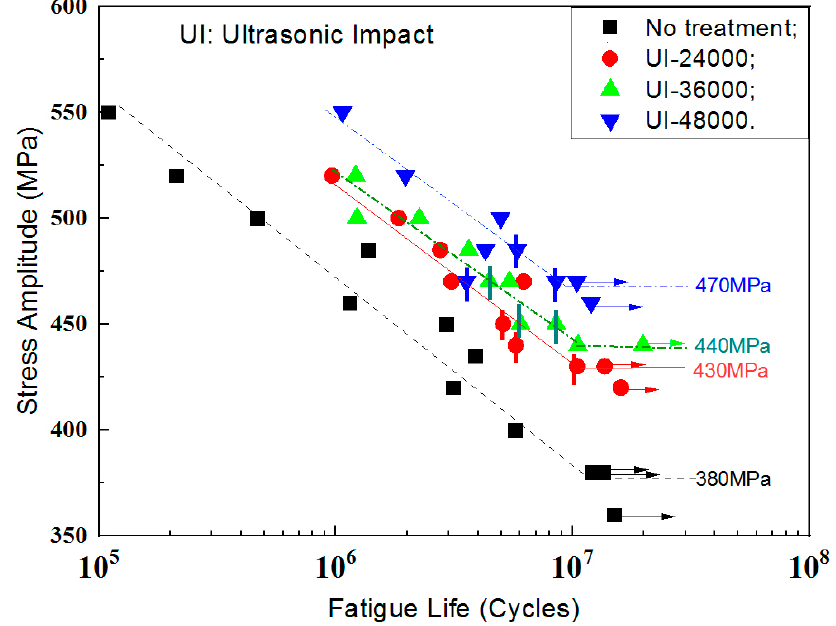
Figure 7. Fatigue S-N curves of TLM titanium alloy.